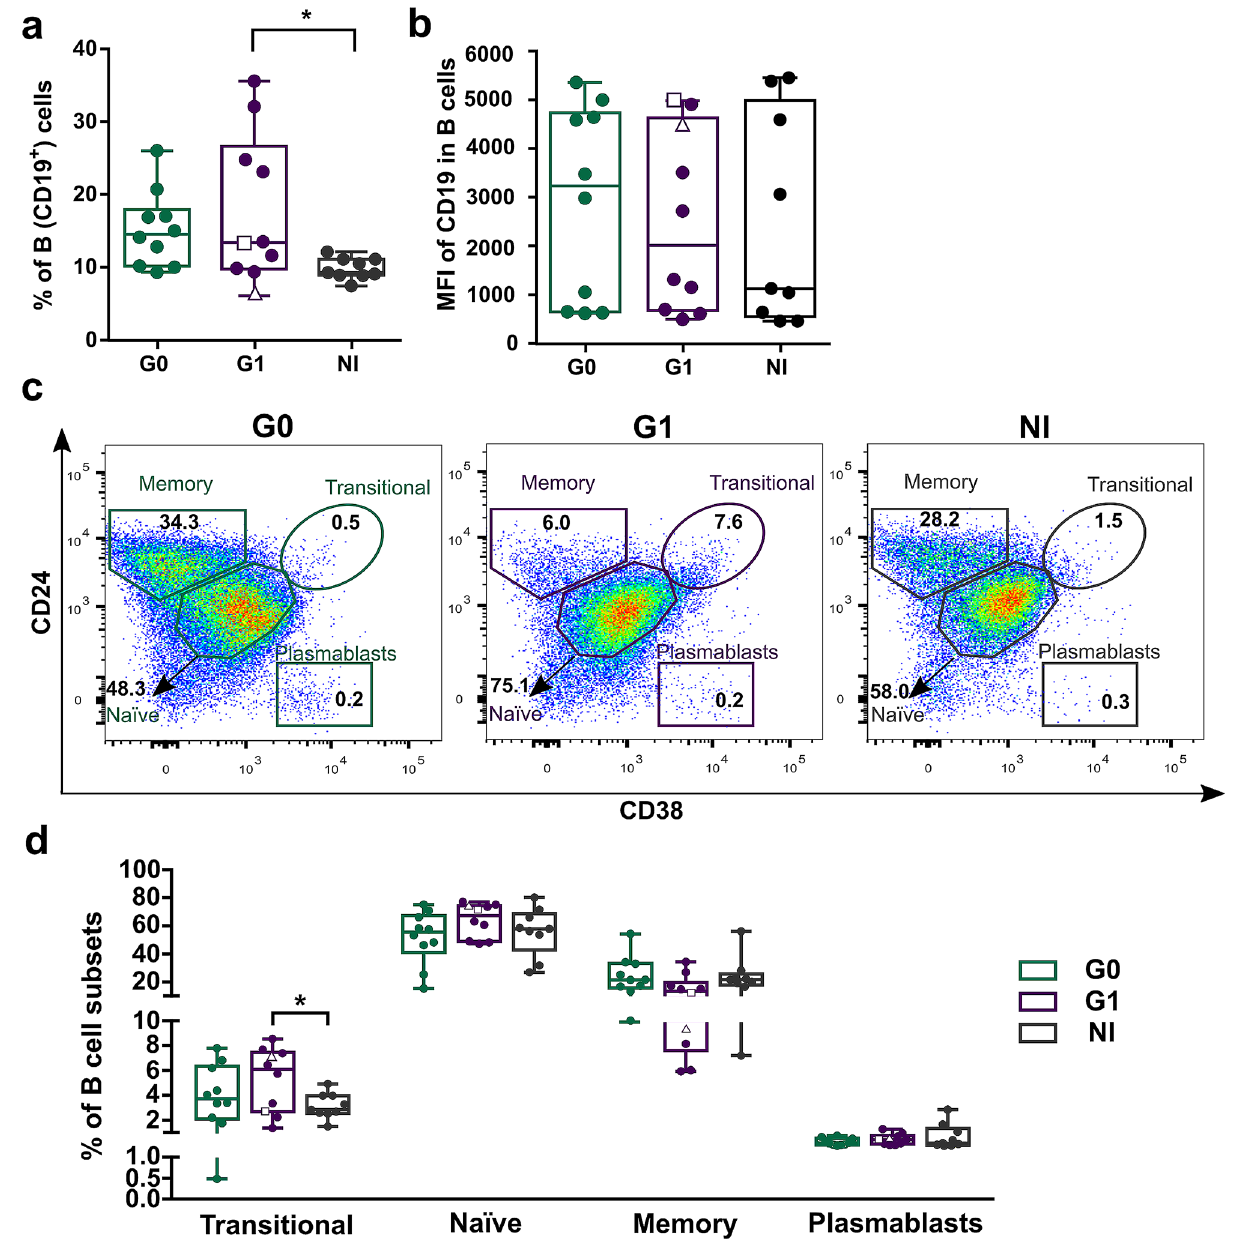
Figure 1. Frequency and phenotypic distribution of total B cells in peripheral blood from chronic Chagas patients and non-infected donors according to CD24 and CD38 expression. ( a,b ) Frequency of B cells (CD3 − CD19 + ) and mean level of CD19 expression (as mean fluorescence intensity; MFI) in the CD3 − CD19 + population from CCD patients (G0, G1) and non-infected donors (NI). ( c ) Representative dot plots from CCD patients and one non-infected donor, showing the gating strategy used to identify B cell subsets. According to CD24 and CD38 expression levels, B cells were sub-gated into: CD19 + CD24 high CD38 high (immature transitional B cells), CD19 + CD24 int CD38 int (mature naïve B cells), CD19 + CD24 high CD38 − (memory B cells), CD19 + CD24 low CD38 high (plasmablasts). ( d ) Frequency of different B cell subsets in total B cells from CCD patients (G0, G1) and non-infected donors (NI). Each dot represents data from one subject; inside G1 group, solid circles correspond to K1 patients, hollow triangle to K2 patient and hollow square to K3 patient. Boxes and whiskers show median value and interquartile range. Statistically significant differences among the groups are indicated (* p <